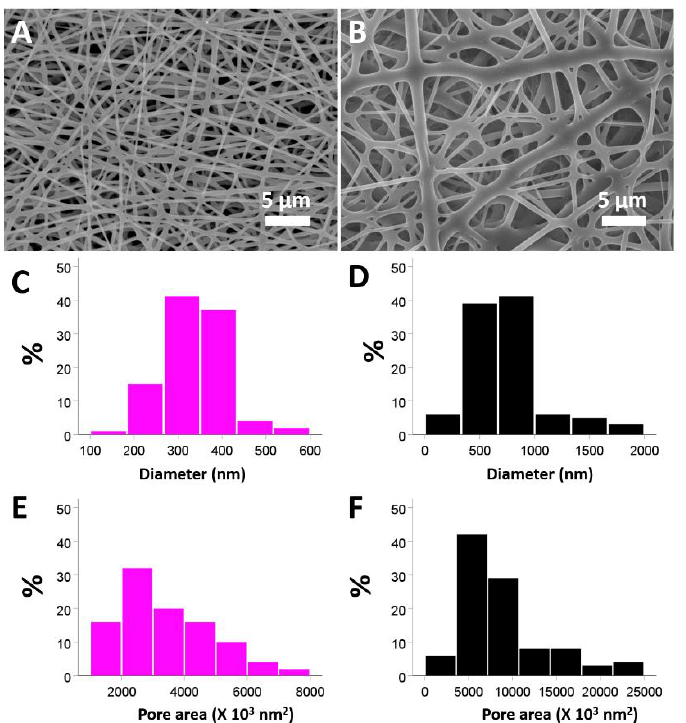
Figure 1. SEM images of electrospun nanofibers composed of PLGA with ( A ) and without ( B ) vildagliptin. Properties of vildagliptin-loaded PLGA ( C ) and drug-free PLGA ( D ) were calculated for the diameters. The pore space in both groups was assessed using Image J software for the vildagliptin group ( E ) and drug-free PLGA groups ( F ) (scale bar: 5 μm).